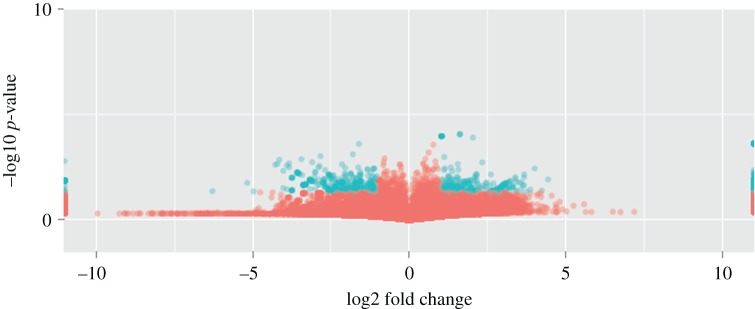
Volcano plots of the differently expressed genes in control group (normal ewes) and treatment group (ovariectomized ewes) longissimus dorsi muscle samples. The blue plots represent the significance; the red plots represent no significance; log2 fold change is equal to log2 (treatment group value/control group value).